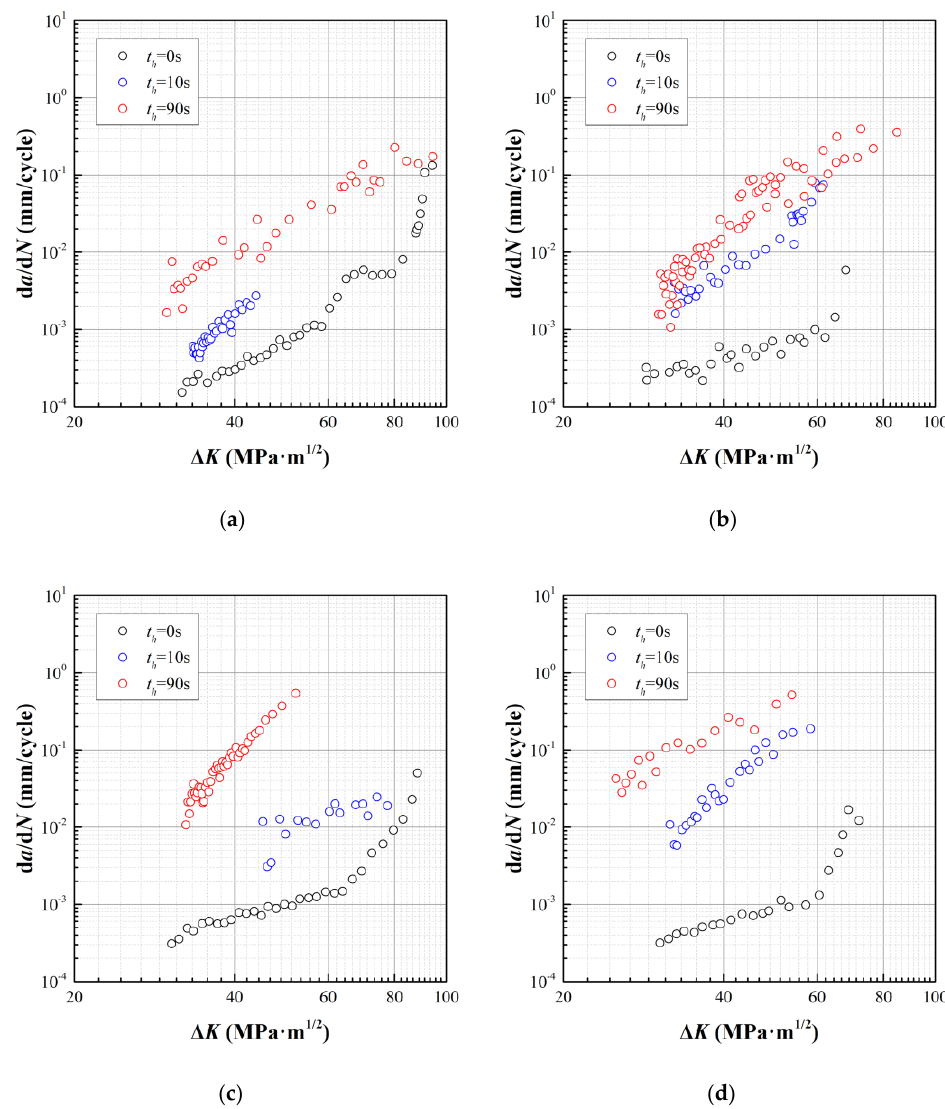
Figure 2. Experimental results of creep-fatigue crack growth at elevated temperatures. ( a ) T = 600 °C, R = 0.1; ( b ) T = 600 °C, R = 0.5; ( c ) T = 700 °C, R = 0.1; ( d ) T = 700 °C, R = 0.5.